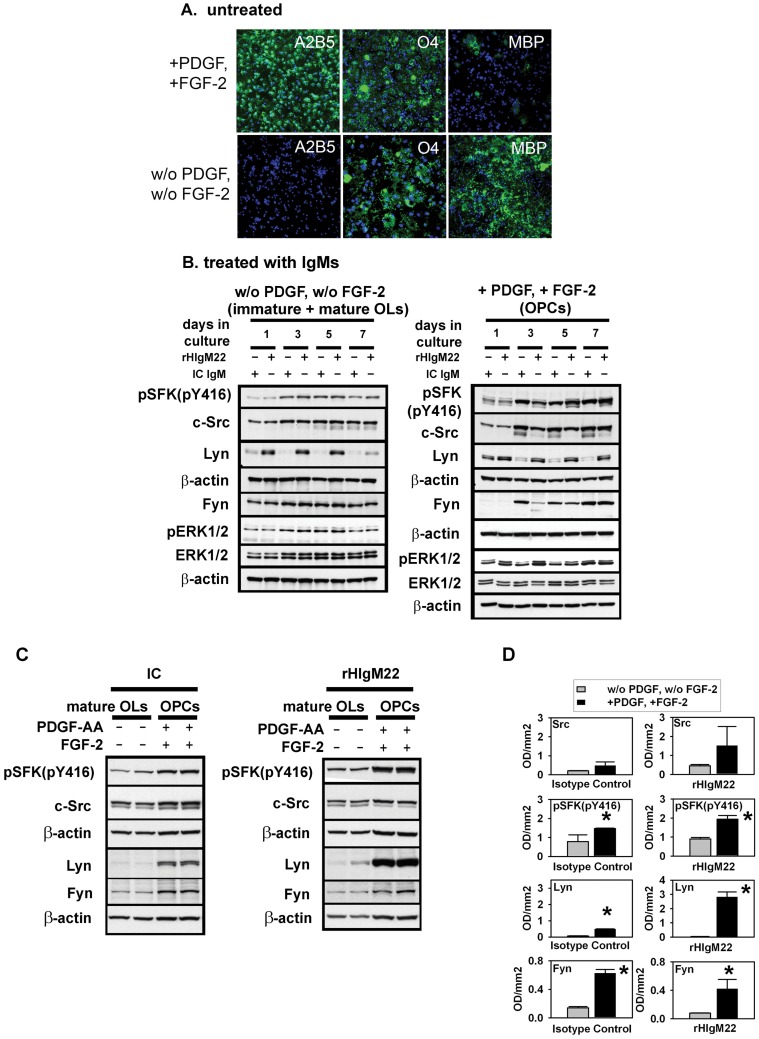
rHIgM22-mediated signal transduction in OPCs requires PDGF and FGF-2. A.OLs were cultured for 7 days on fibronectin in the presence or absence of growth factors PDGF-AA and FGF-2. OLs were pre-labeled with rHIgM22 (10 µg/ml), O4 (10 µg/ml) or A2B5 (10 µg/ml) for 30 minutes in HMEM at 8 °C, fixed and processed for immunocytochemistry including DAPI-staining. For MBP-staining, OLs were fixed, permeabilized and stained with anti-MBP (MBP staining = green, DAPI = blue). Results were repeated 3 times with identical results. B+C. OLs were cultured identical to A and treated with rHIgM22 (5 µg/ml) or isotype-control IgM (IC) (5 µg/ml) in the absence or presence of growth factors PDGF-AA and FGF-2. B. Comparison of OPCs with OPCs (+PDGF/FGF-2) and mature OLs with mature OLs (w/o PDGF/w/o FGF-2). Representative blots showing the levels of phospho-SFKs (pY416), phospho-p44/42 MAP Kinase (pT202/pY204) (pERK1/2), Lyn, Fyn, c-Src, p44/42 MAP Kinase (ERK1/2) and β-actin as a loading control at day 1, 3, 5 and 7 in culture. C. Comparison of OPCs and mature OLs on the same Western blot. Representative Western blots showing levels of activated SFKs (pY416), Lyn, Fyn, c-Src and β-actin as a loading control at day 7 in culture. Each sample is loaded as a doublet. D. Quantitative analysis of 3 independent experiments as described in C. Background is subtracted from each value and normalized against β-actin levels. Data are presented as mean ± S.D. (n = 3). * p<0.05 compared to controls.